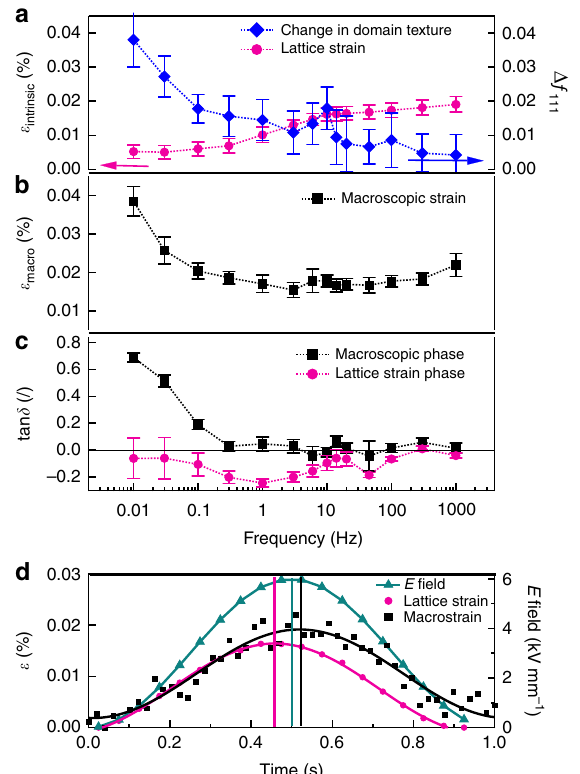
Fig. 3 Effect of electric fi eld cycling as a function of frequency. a Calculated total lattice strain (magenta circles), ε intrinsic , using equation (3), and change in non-180° 111 pc domain texture (blue diamonds), Δ f 111 , using equation (2); b measured in situ macroscopic strain, ε macro , by an optical displacement sensor coupled to the sample surface during XRD experiments (see Methods); c tangent of the piezoelectric phase angle, tan δ , of macroscopic strain (black squares) and lattice strain (magenta circles) during application of 6 kV mm − 1 unipolar sinusoidal electric fi eld, E ; and d time dependence of driving electric fi eld (turquoise triangles), macroscopic strain (black squares), and lattice strain (magenta circles) responses demonstrated at 1 Hz, showing lagging (black straight line) and leading (magenta straight line) between strain and sinusoidal fi eld